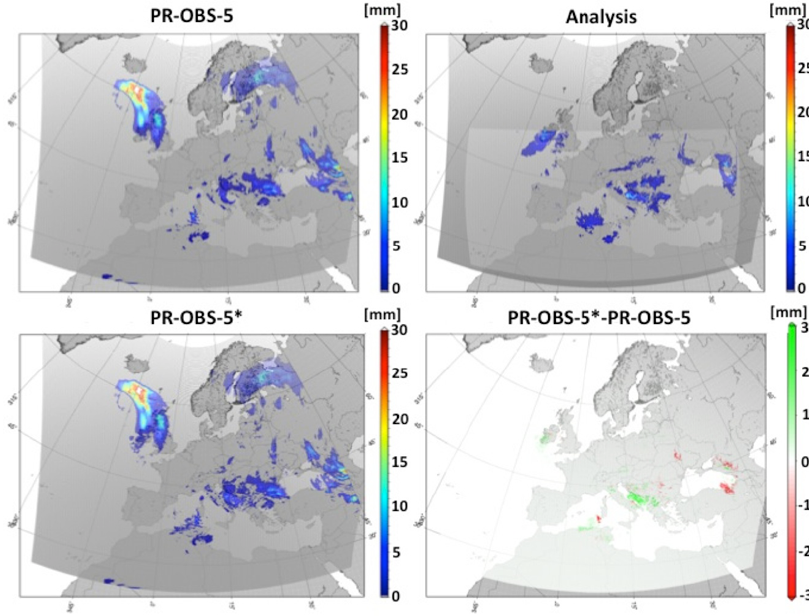
Fig. 5. PR-OBS-5 generated 6-hour accumulated precipitation on 17 April 2012: top left panel shows results from current operational algorithm (PR-OBS-5); top right panel shows results from analysis step; bottom left panel shows results from new version of algorithm (PR-OBS-5*); and bottom right panel shows differences between new and original versions of the algorithm